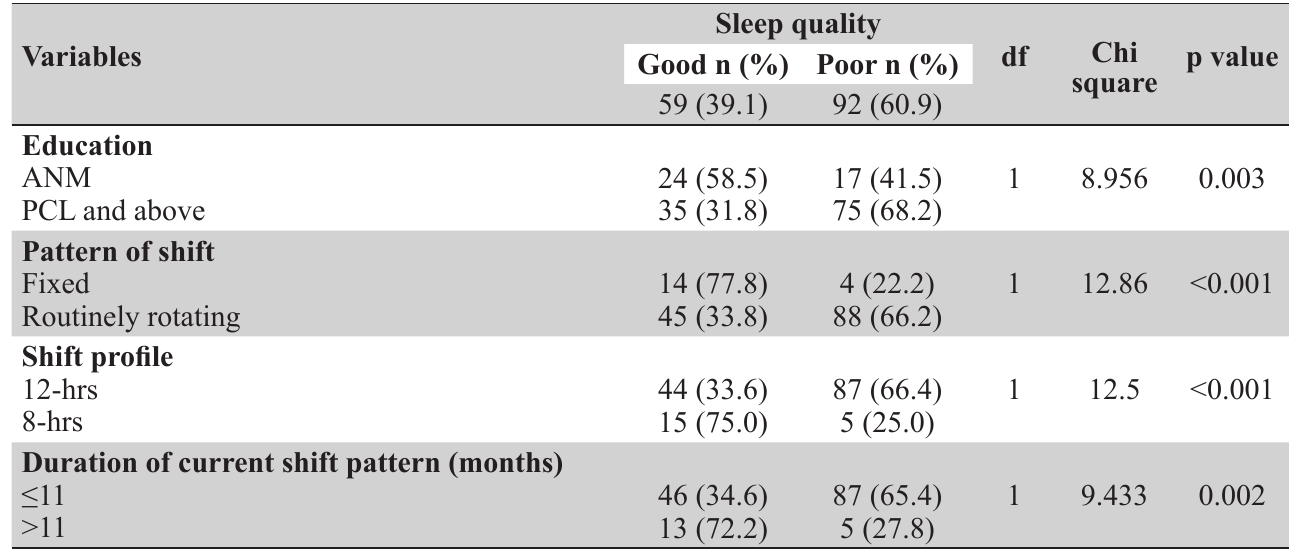
Table 3: Association between sleep quality and selected variables of the participants (n=151).